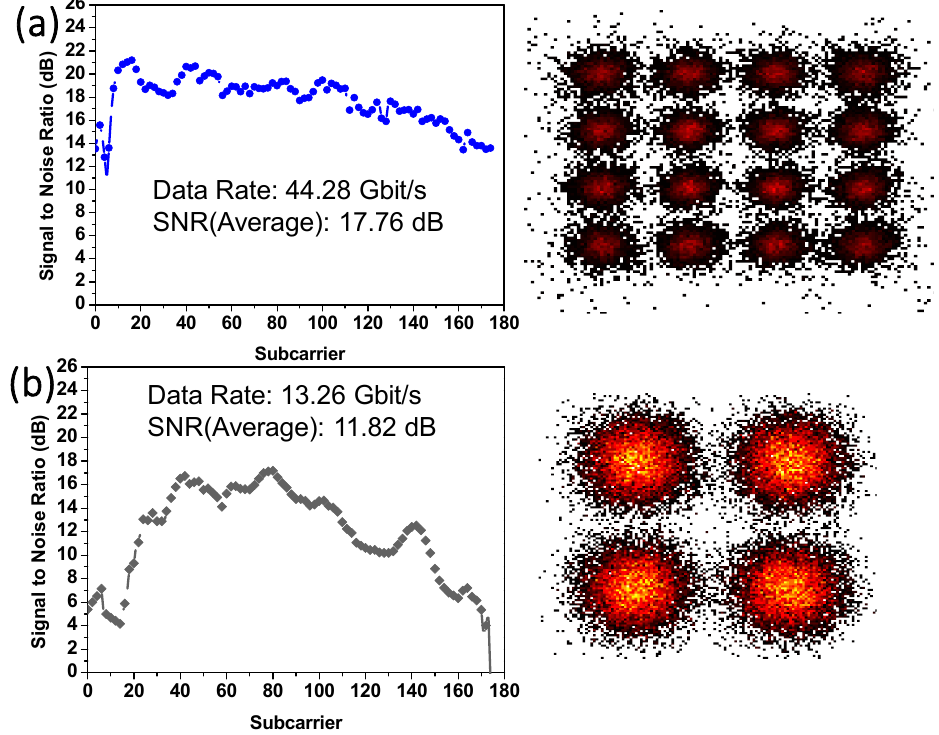
Figure 11. Measured SNRs of NOMA ( a ) Data 2 and ( b ) Data 1 over all the 170 OFDM subcarriers at MDM TE 1 mode, with corresponding constellation diagrams of the NOMA Data 2 and Data 1 .